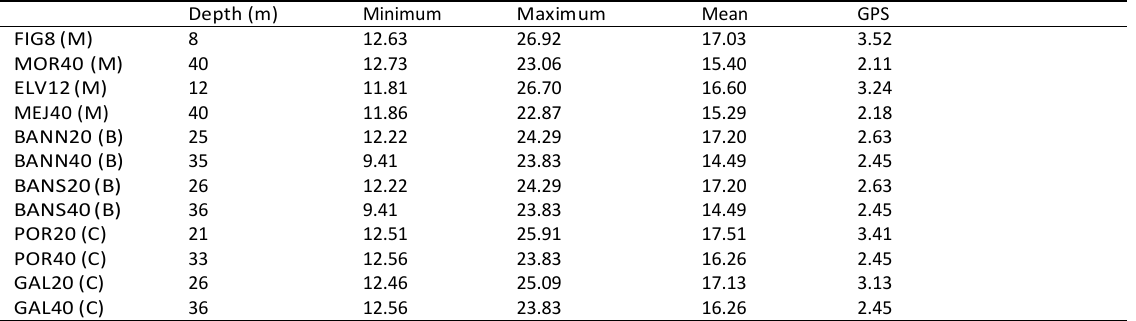
Table 2. Temperatures (in °C) characteristics of the sampling sites from March 2012 to October 2014. The corresponding regions are indicated by a letter: M – Marseille, B – Banyuls, C - Corsica Depth (m) Minimum FIG8 (M)